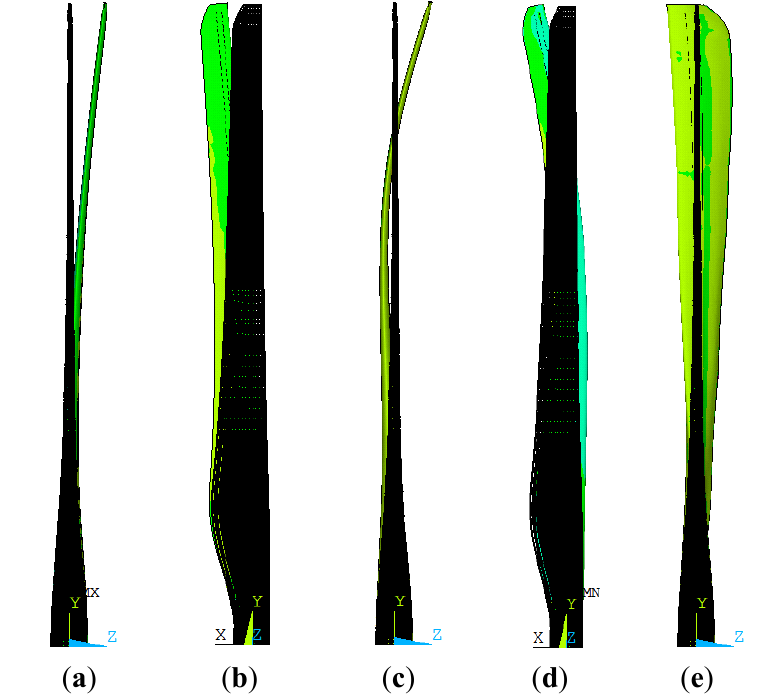
Figure 8. Mode shape of blade ( a ) 1st-flapwise; ( b ) 2nd-eigewise; ( c ) 3rd-flapwise; ( d ) 4th-eigewise; ( e )